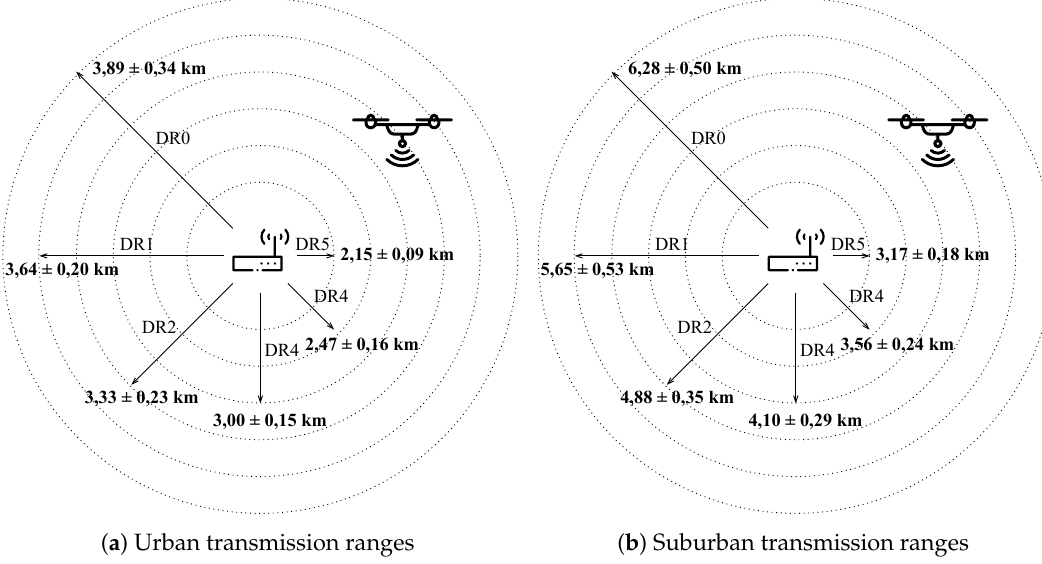
Figure 5. Transmission ranges in urban and suburban scenarios.